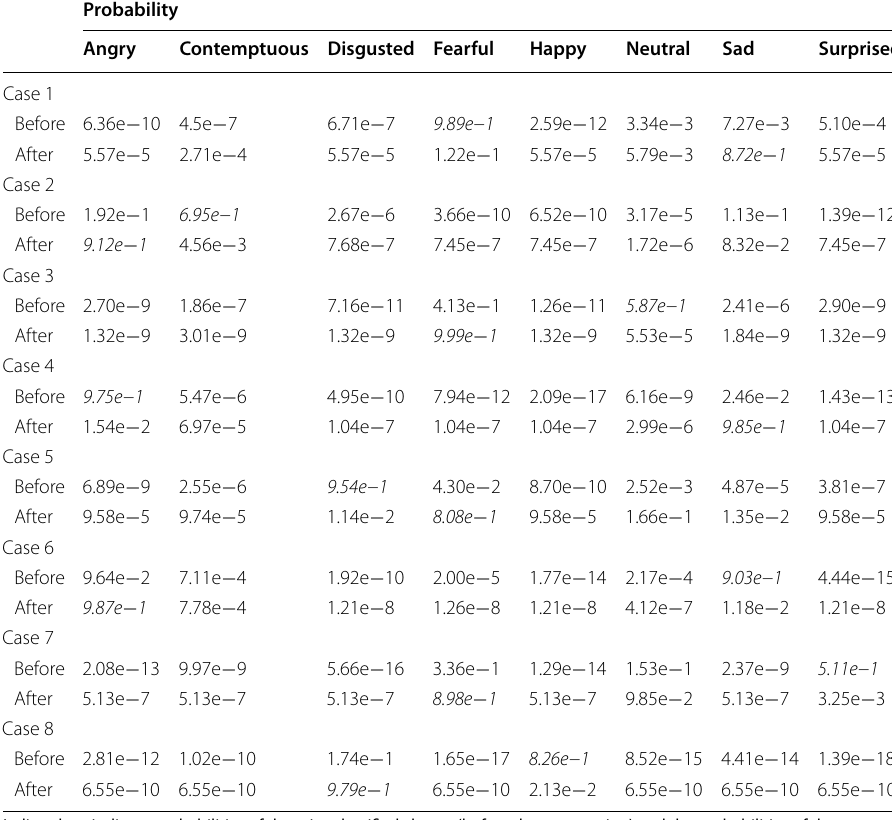
Table 3 The distribution of